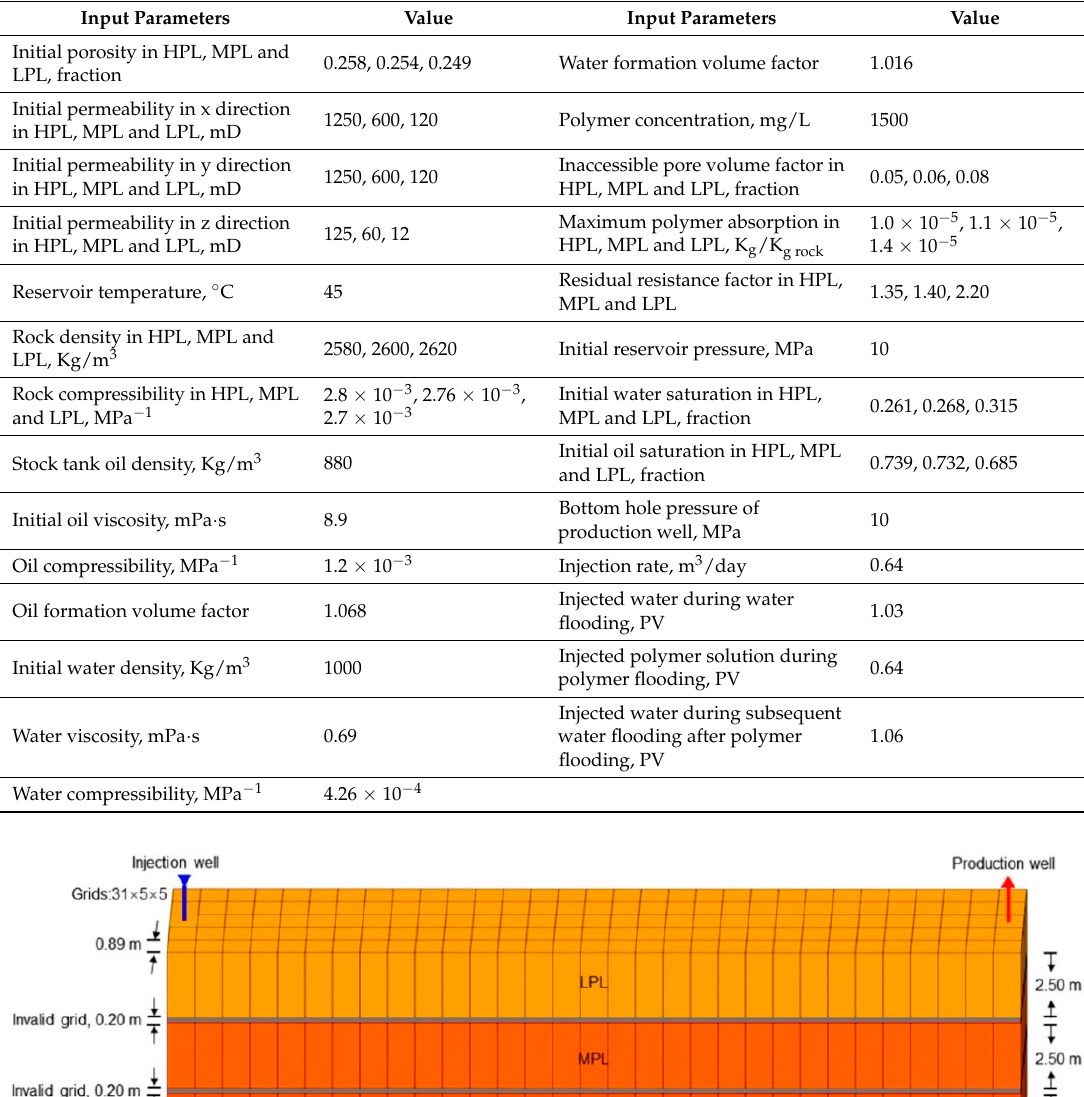
Table 5. The reservoir property, fluid property, initial conditions and production data of the case without polymer degradation.